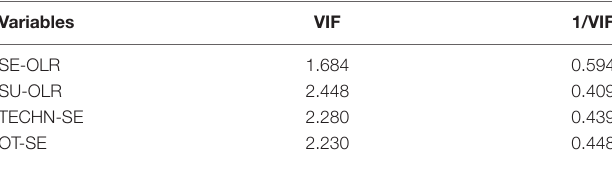
TABLE 6 | Variance inflation factor